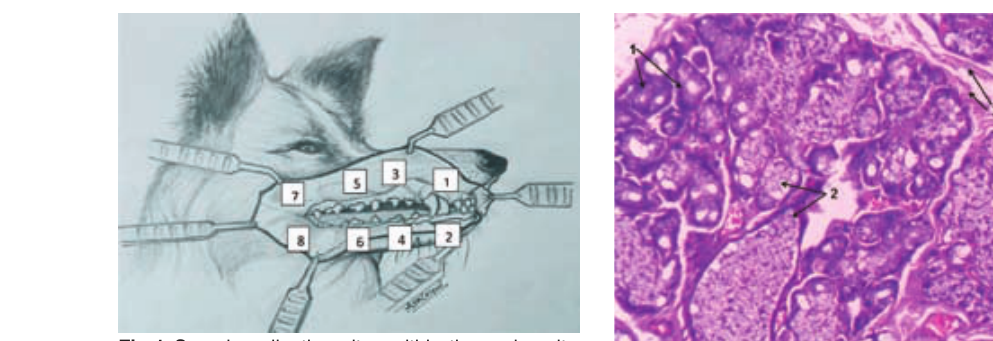
Fig.1 Sample collection sites within the oral cavity. Samples were collected from the upper rostral labial mucosa (1), lower rostral labial mucosa (2), upper labial mucosa from canine to third premolar (3)and (5), lower labial mucosa from canine to third premolar (4) and (6) and buccal mucosa near the commissure (7) and